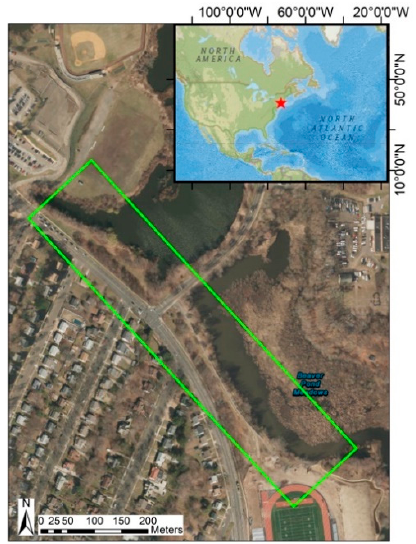
Figure 1. The satellite map of Beaver Pond Park, New Haven, Connecticut, United States, with an inset map indicating its location. The green box indicates the approximate area covered by the UAV observation.